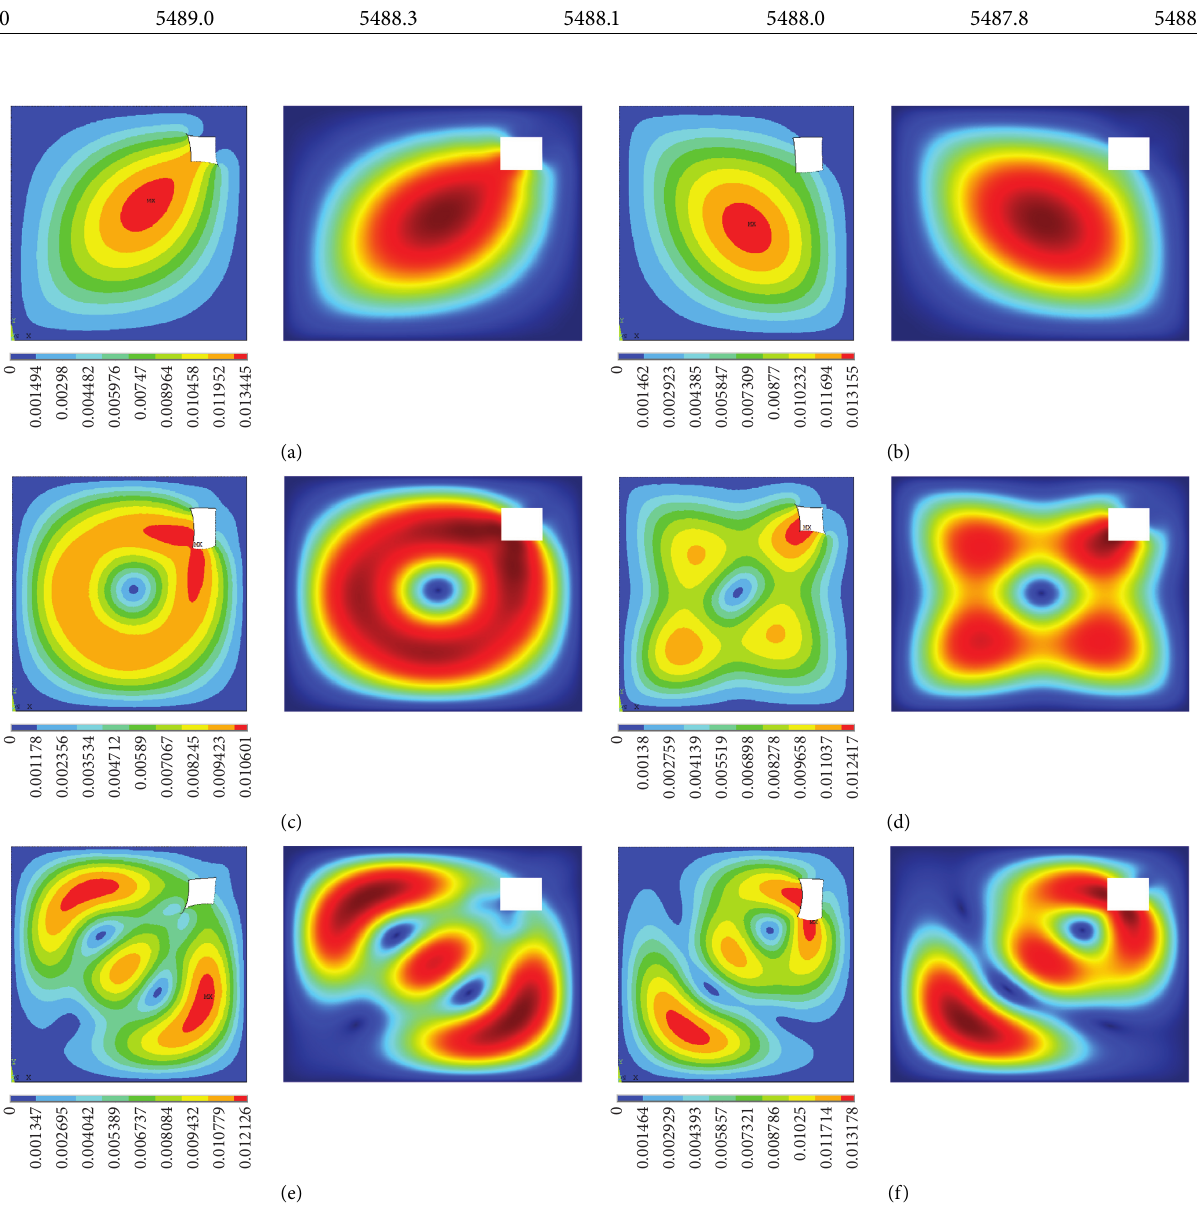
Figure 2: The mode shapes of the square plate with an inner cutout. (a) The first mode shape; (b) the second mode shape; (c) the third mode shape; (d) the fourth mode shape; (e) the fifth mode shape; (f) the sixth mode shape. Left: the ANSYS results; right: the present